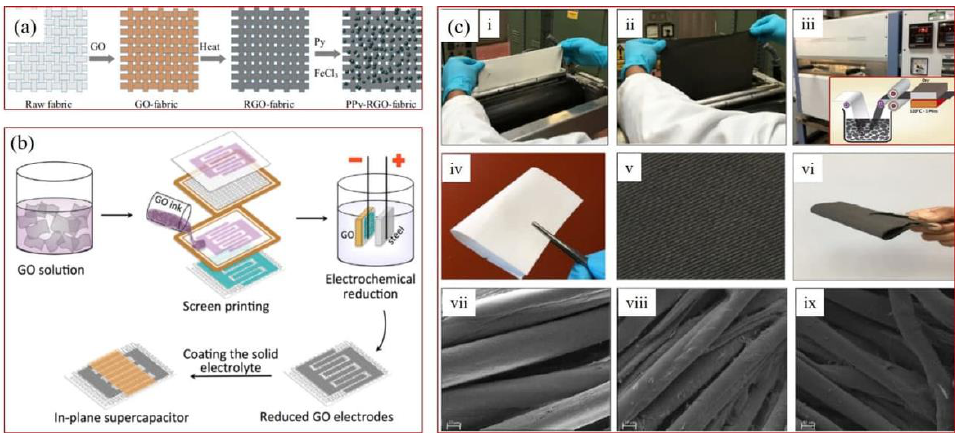
Figure 1. ( a ) Schematic for fabrication of PPy-rGO-fabric. ( b ) Schematic of the printed superconductor fabrication process. ( c ) Scalable production of rGO-coated cotton fabric using padding bath with rollers. Reprinted with permission from References [25 – 27]. The inset of c(iii) is the scheme of the pad-dry process. Copyright (2015) Elsevier, Copyright (2017) IOP Publishing, and Copyright (2017) American Chemical Society.